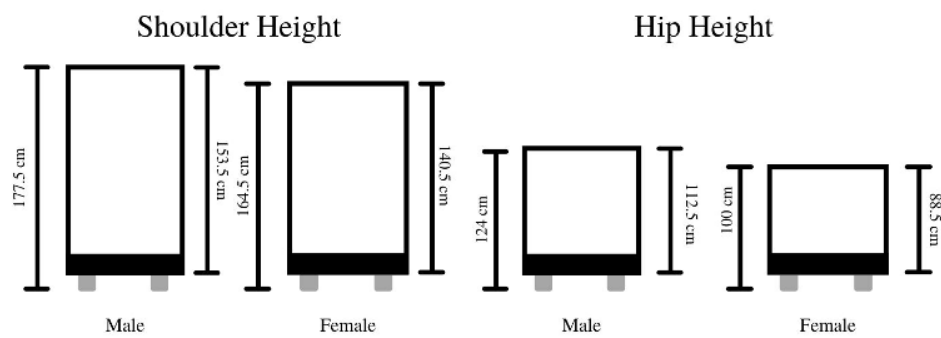
Figure 3. Illustration of the two handle heights for both males and females.